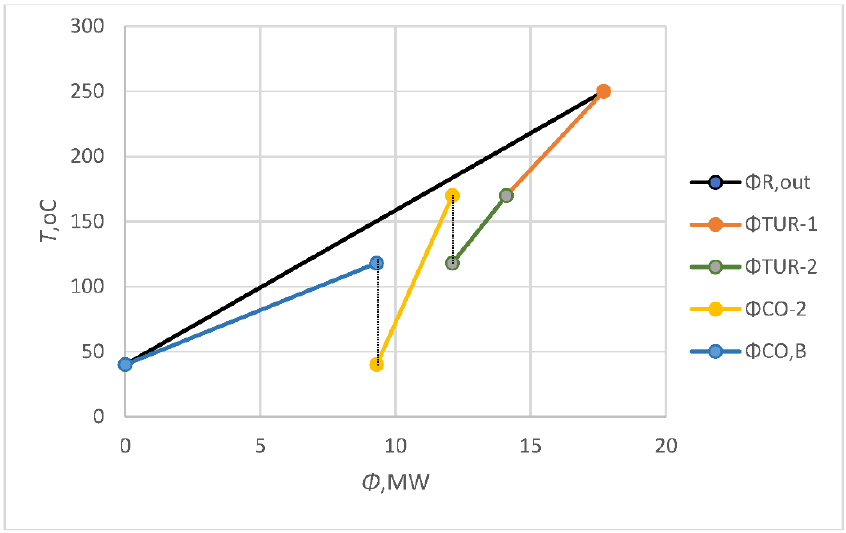
Figure 4. The usage of electricity cogenerations with two gas turbines, including cooling.